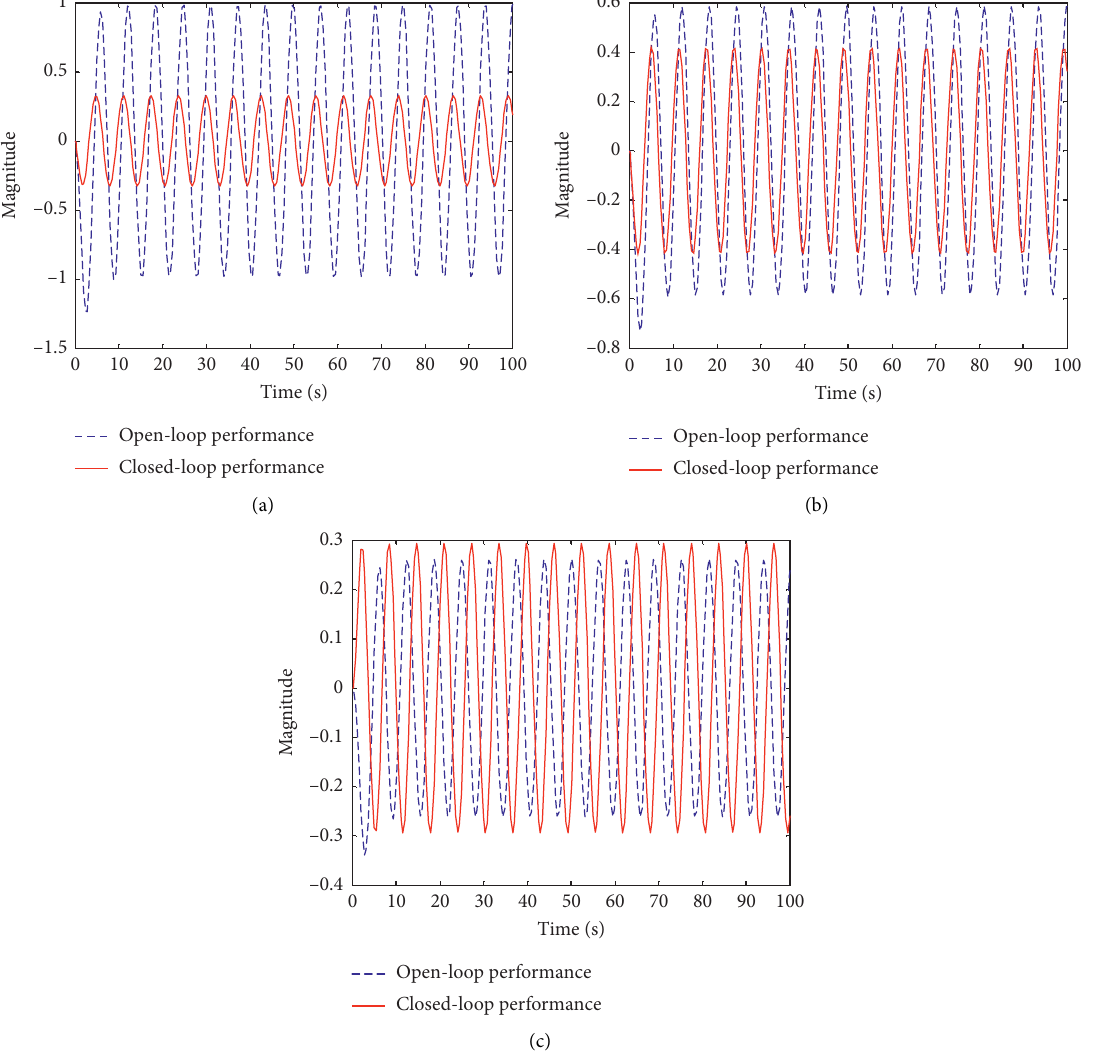
Figure 1: Restricted active vibration distribution through single node control: (a) node 1 performance; (b) node 2 performance; (c) node 3